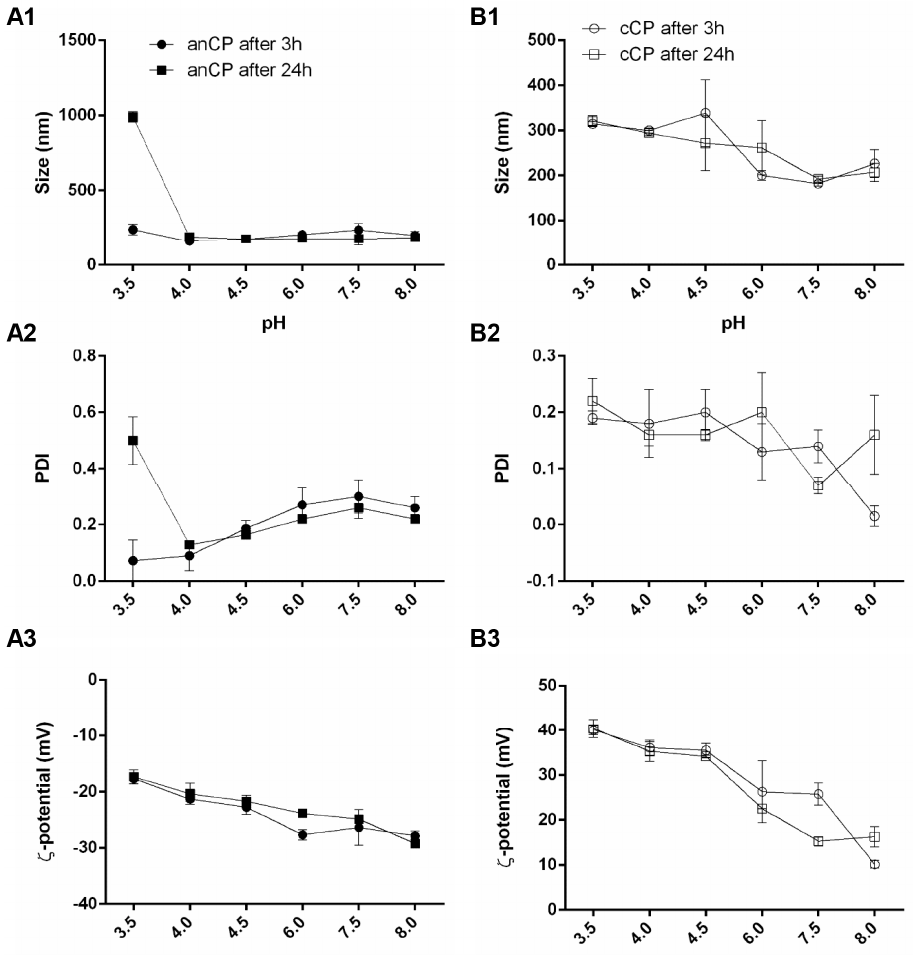
Figure 2. Characteristics of anionic core polyplexes (anCP, A1 , A2 and A3 ) and Protasan-coated core polyplexes (cCP, B1 , B2 and B3 ) after 3 h and 24 h incubation in pH conditions ranging from 3.5 to 8.0. The pH-values changed accordingly starting from an initial pH-value of the samples of 5.5. n = 3, mean ±